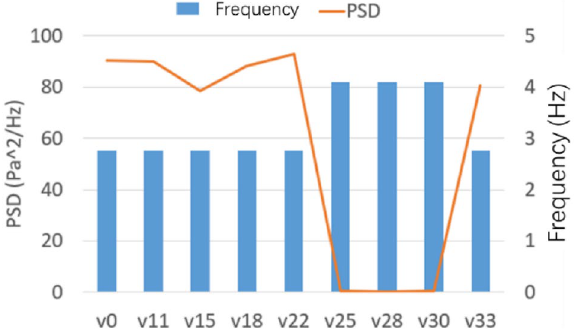
Figure 45. PSD histogram at each